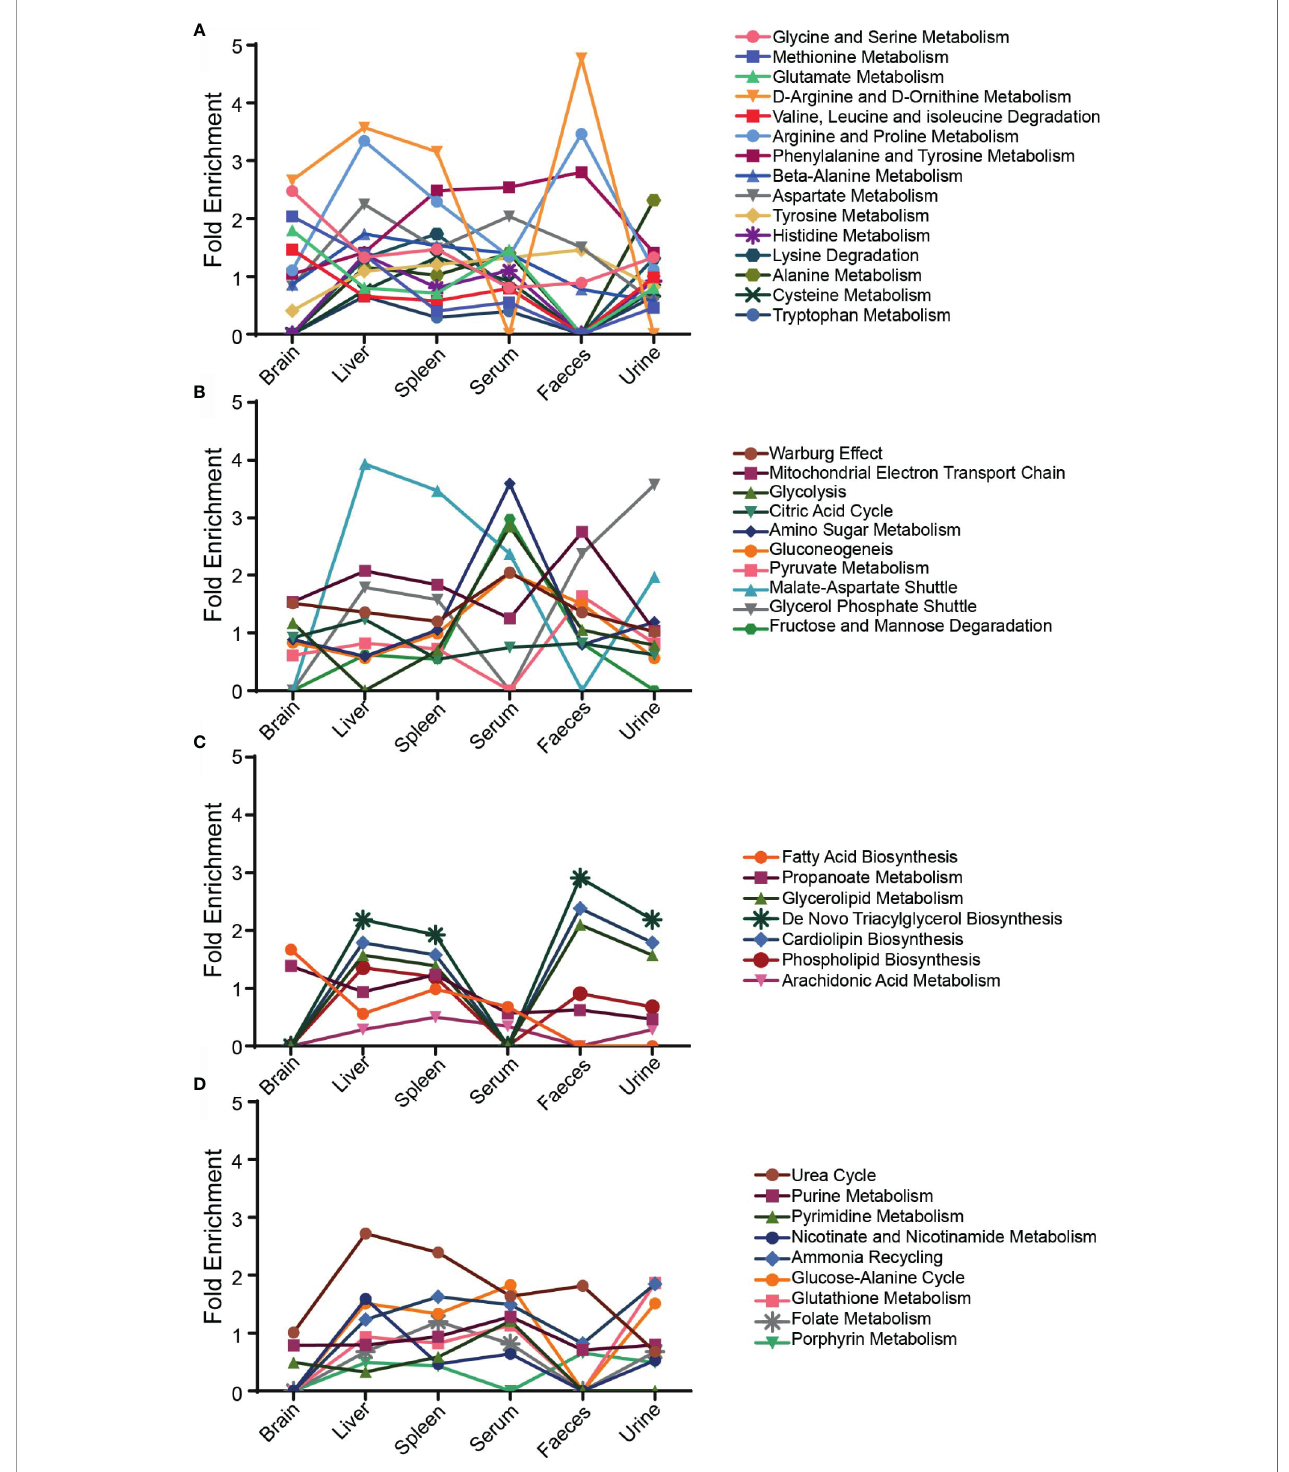
FIGURE 5 | Fold enrichment with ORA. Pathway enrichment in different tissues and bio fl uids of the control vs infected samples was classi fi ed into four groups — (A) Amino acid metabolic pathways, (B) Energy related metabolic pathways, (C) Lipids and fatty acid metabolic pathways and (D) a miscellaneous group. ORA was implemented using the hypergeometric test to evaluate whether a particular metabolite set is represented more than expected by chance within the given compound list. It uses HMDB as a reference metabolome to calculate a background distribution to determine if the matched metabolite set is more enriched for a certain metabolite as compared to random